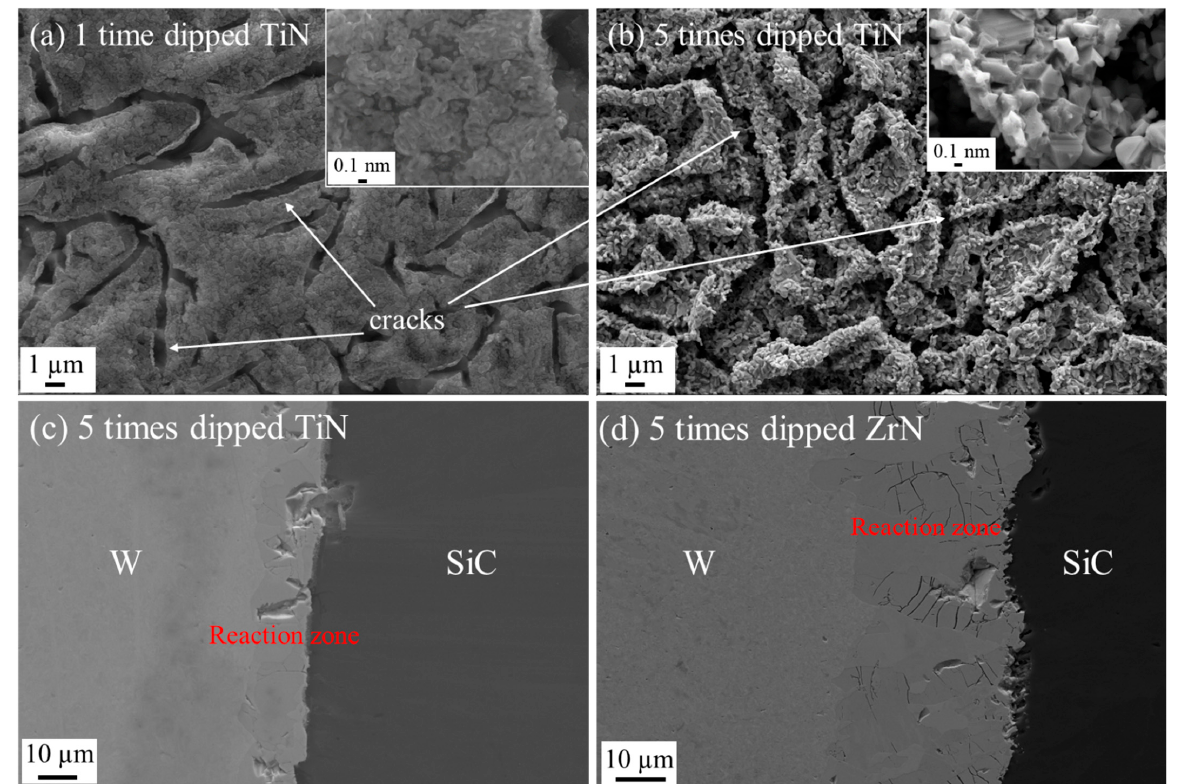
Figure 10. The surface and cross-sectional SEM images of dipped nitride coated SiC before and after joined with W foil at 1700 °C with 20 MPa pressure. ( a ) the surface of 1-time dipped TiN on CVD-SiC with different magnifications; ( b ) the surface of 5-times dipped TiN film; ( c ) the cross-sectional of 5 times dipped TiN-coated SiC joined with W; ( d ) the cross-sectional of 5-times dipped ZrN-coated SiC joined with W.